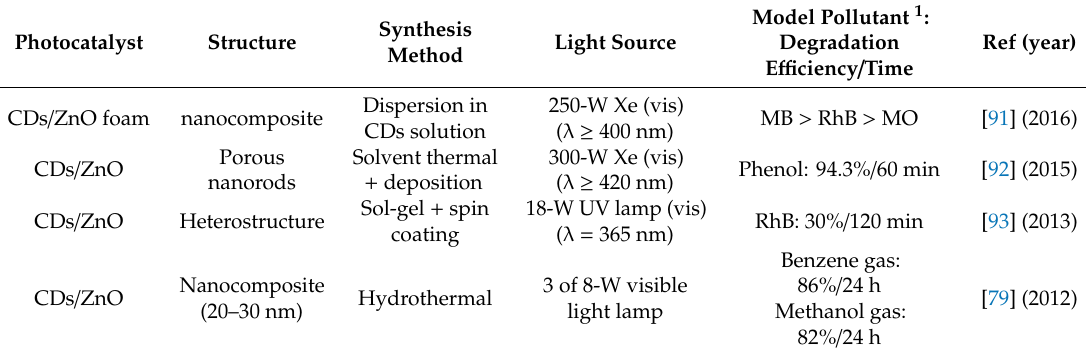
Table 5. Photocatalytic degradation activity of CDs /